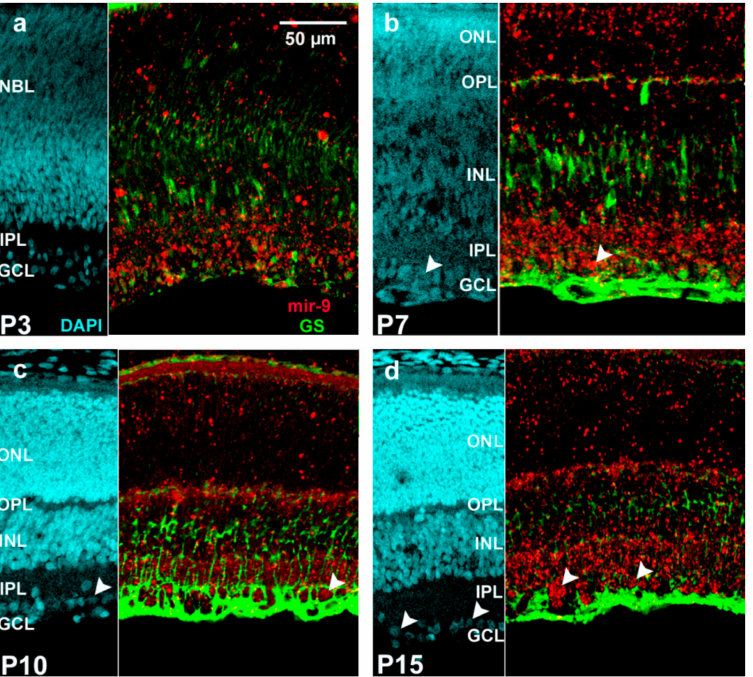
Figure 6. Representative images of miR-9 (red: TSA Cy 3) co-detection with Müller glia-specific marker protein (glutamine synthetase (GS); green: Alexa Fluor-488) at the indicated postnatal days (( a ) P3, ( b ) P7, ( c ) P10, ( d ) P15). Non-co-localized cells are demonstrated by arrowheads. The scale bar represents 50 µ m. GCL, ganglion cell layer; IPL, inner plexiform layer; NBL, neuroblast layer; INL, inner nuclear layer; OPL, outer plexiform layer; ONL, outer nuclear